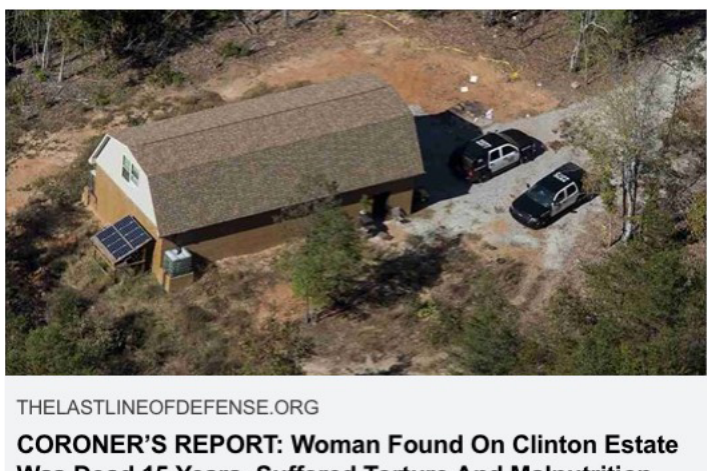
Figure 1. Example news headline with picture, headline, byline, and